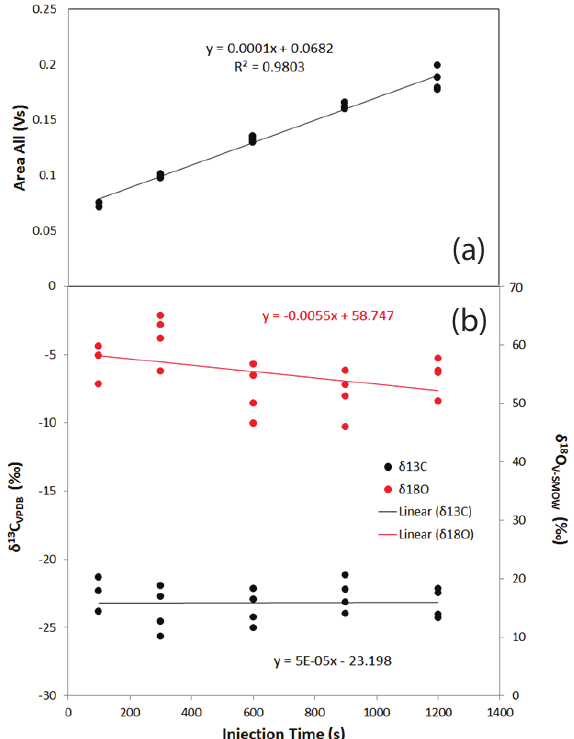
Figure 4. Dependence of the peak area all (a) and δ 13 C and δ 18 O (b) on the injection time for blank runs, i.e. when the sample inlet valve was actually not opened. The peak area of the blank increases approximately linearly with injection time, and the dependence of the isotope values on injection time is relatively small. Note that the scatter in the isotopic composition measurements is so large because of the very small peak areas of these blank